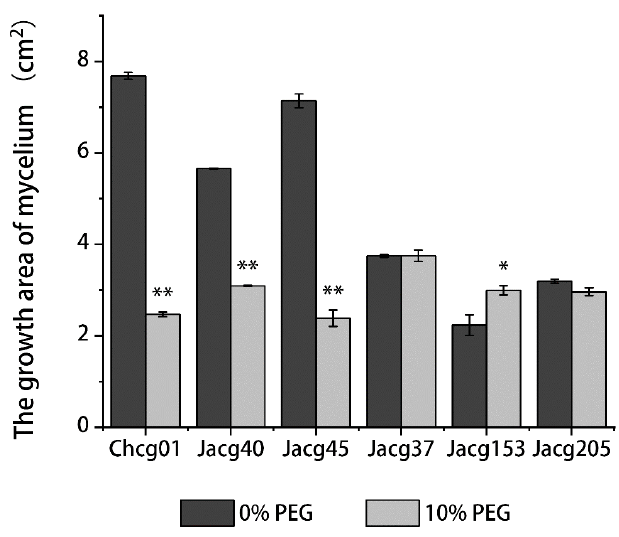
Figure 1. The mycelial growth of six strains of Cenococcum geophilum under drought treatments. The mycelia were pre-cultured in a modified MMN medium for 30 days, followed by the drought treatment (10% PEG-6000) for 30 days. PEG-6000 was not added into the control treatment. Data and bars are shown as mean and ± SD of the replicates, respectively (n = 3). Significant difference is analyzed by using the S tudent’s t -test. * p < 0.05; ** p < 0.01.